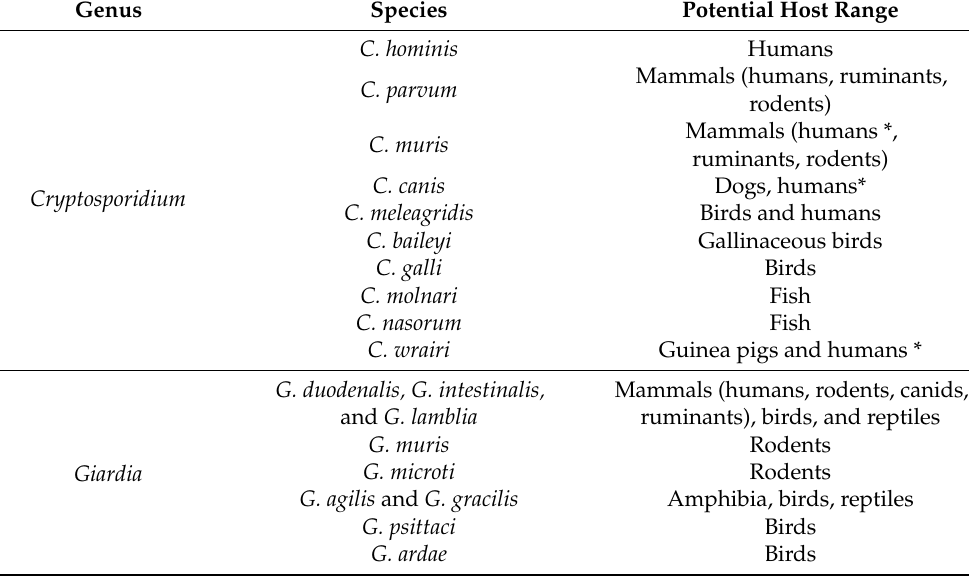
Table 1. Cryptosporidium spp. and Giardia spp. potential host range. Information from [32,33]. Genus Species Potential Host Range